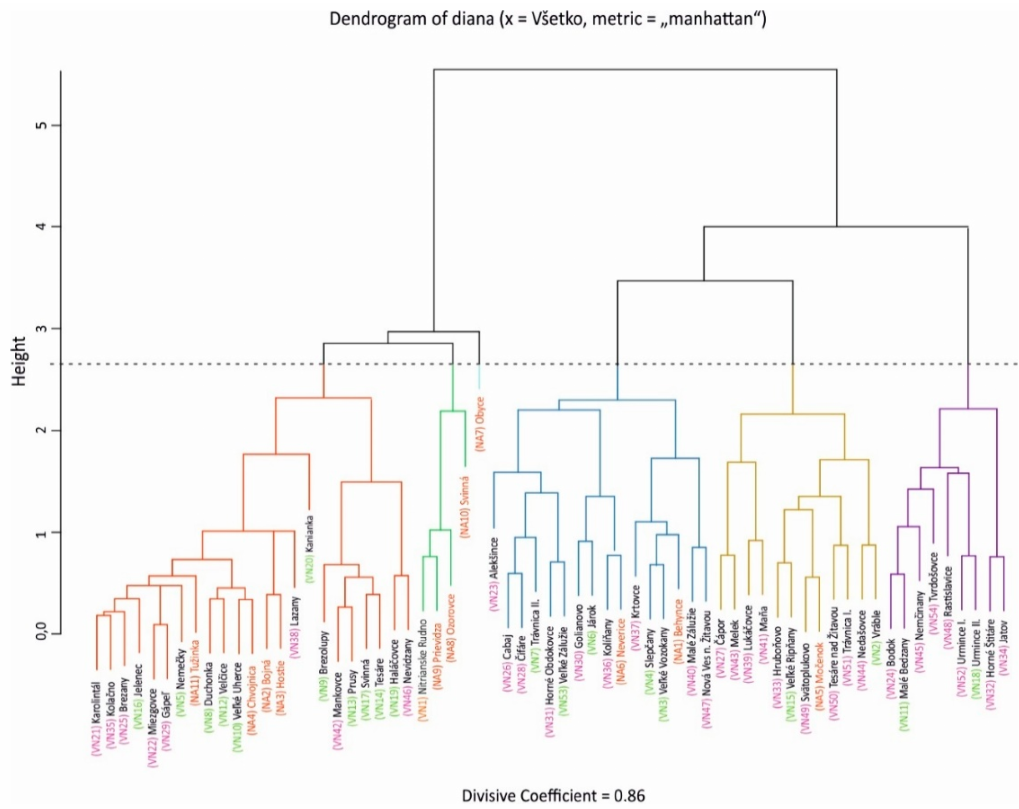
Figure 6. Divisive analysis (DIANA) of hierarchical clustering with Manhattan metric, including “all the criteria” (Divisive Coe ffi cient = 0.86).